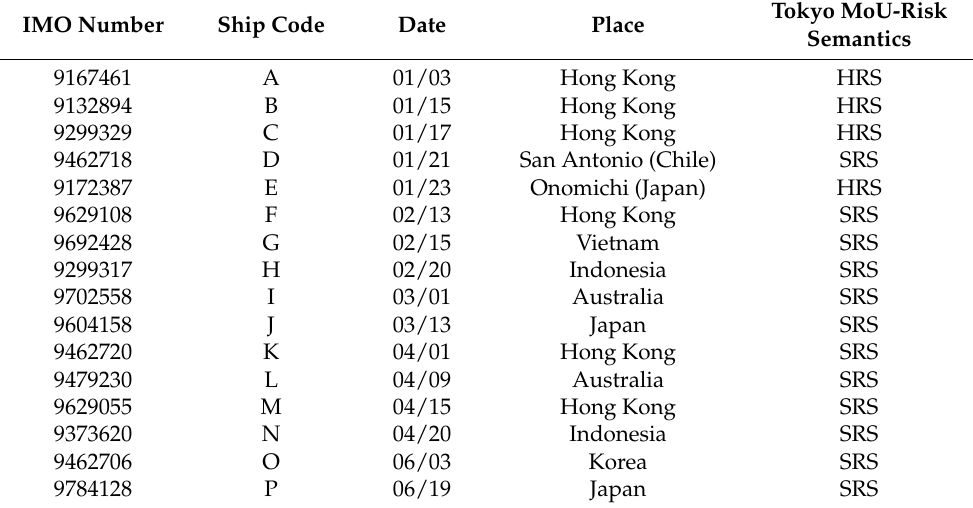
Table 11. Inspection data of Taiwanese ships.